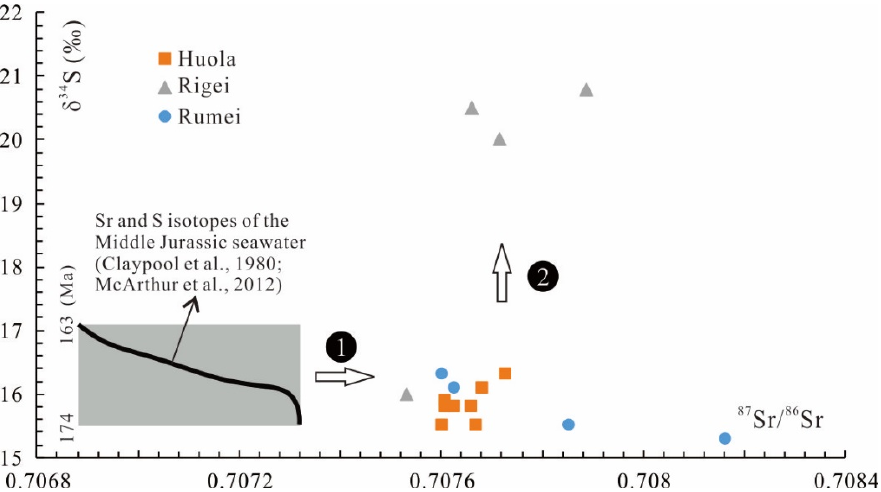
Figure 6. Sr vs. S isotopes of Middle Jurassic sulphates in the Qamdo Basin. Process 1: the inflow of continental flux with more radiogenic 87 Sr elevated the 87 Sr/ 86 Sr ratios of evaporates; process 2: bacterial sulphate reduction increased the δ 34 S values [9,23].